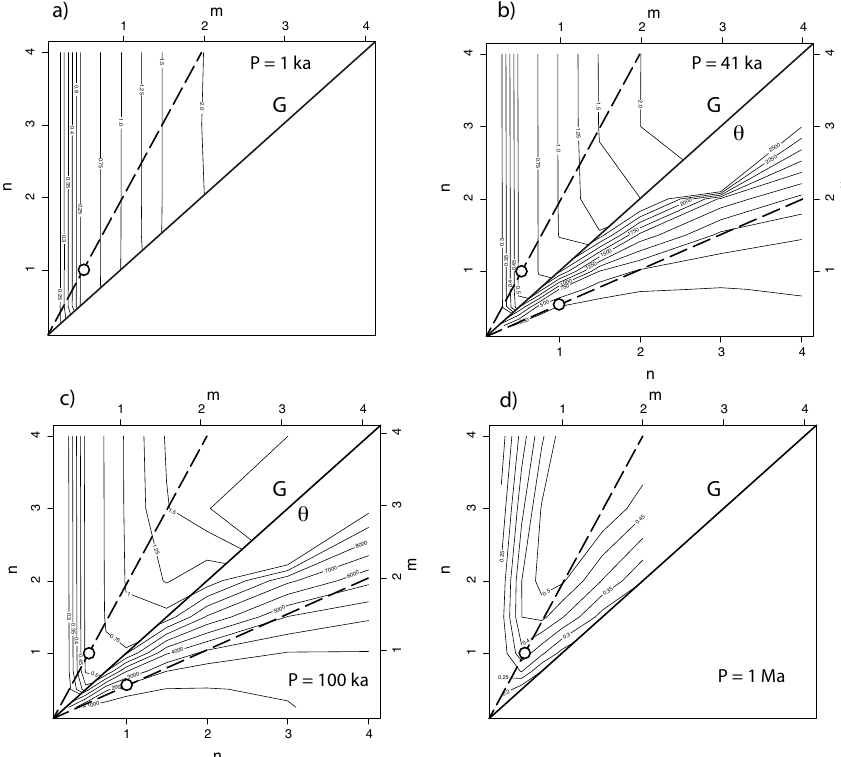
Figure 5. Contour plots of computed gain G (upper left half of each panel), and time lag θ (lower right half of b and c ), as a function of the stream power law exponents m and n for different forcing periods: (a) 1ka, (b) 41ka, (c) 100ka and (d) 1Ma. U is 6mma − 1 and p = 2 in all model runs. Contour labels for θ are in years; G is a dimensionless quantity. The dashed lines correspond to m/n = 0.5, a commonly accepted value derived from river profile concavity measurements. The circles correspond to the preferred values for n ( = 1) and m ( = 0.5). Gain and time lag were only computed for values of n ≥ m